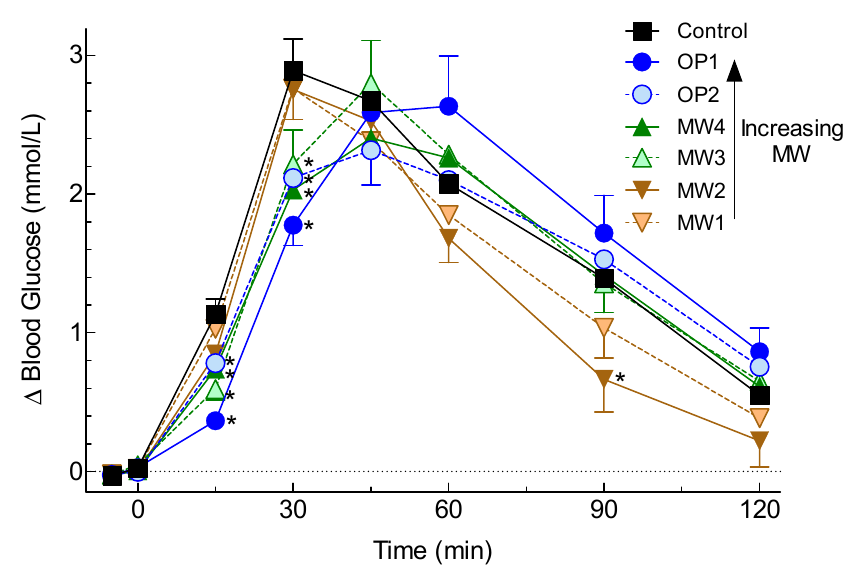
Figure 1. Glycemic responses elicited by the test meals. Values are means ± SEM for n = 16 subjects. The Control (200 mL water) and oat β -glucan preloads (MW1, MW2, MW3, MW4, OP1, and OP2 added to 200 mL water) were taken 2–3 min before consuming ~113 g white bread. * Significantly different from the Control by Dunnett’s test for two-tailed p < 0.05.